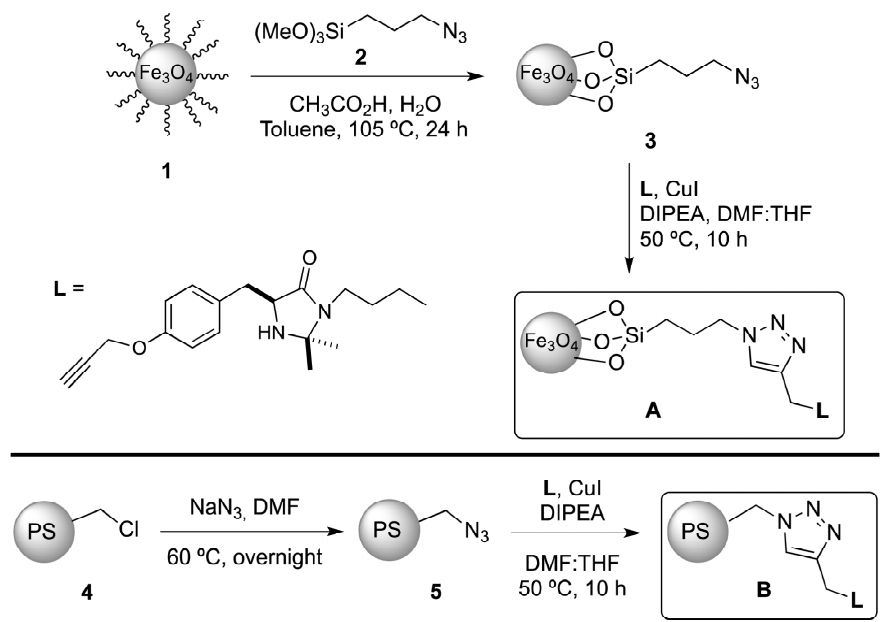
Figure 8. Scheme for the immobilisation of first generation Macmillan catalysts on the surface of magnetic nanoparticles and polystyrene microspheres. Reproduced from Pericàs et al. [67]. Copyright 2012 American Chemical